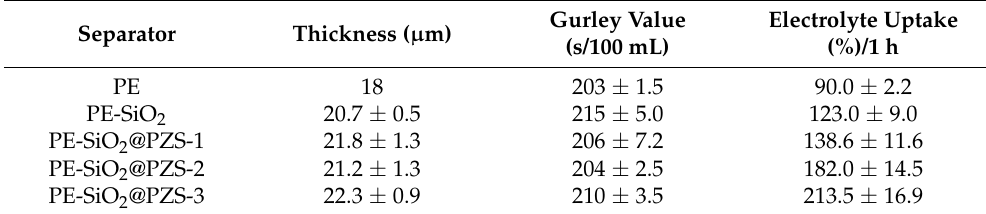
Table 2. Physical properties of PE membrane, PE-SiO 2 , PE-SiO2@PZS-1, PE-SiO2@PZS-2 and